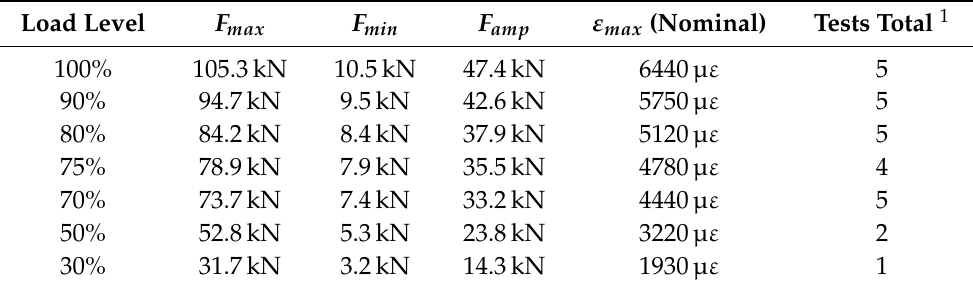
Table 2. Load levels for the CCAI tests and the distribution of the